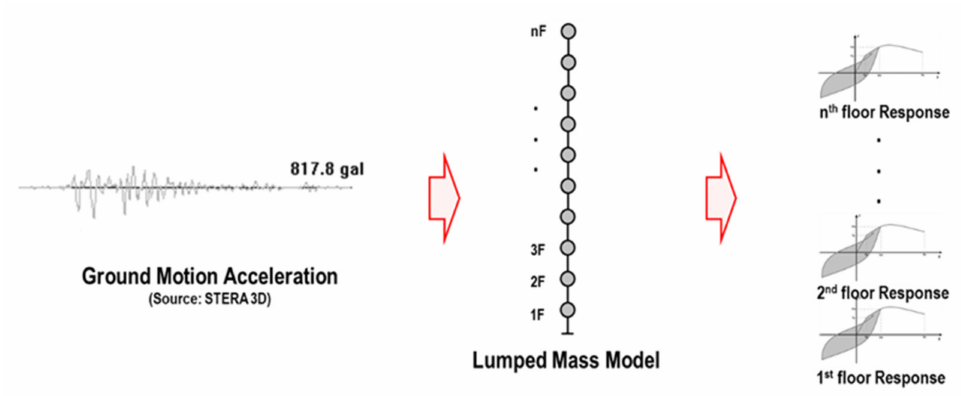
Figure 2. The general process of structural analysis.